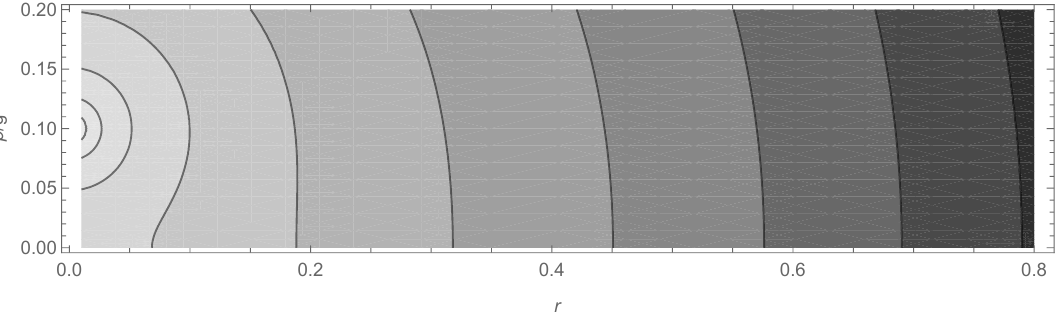
Figure 2 . Equipotential surfaces of a Type II potential.